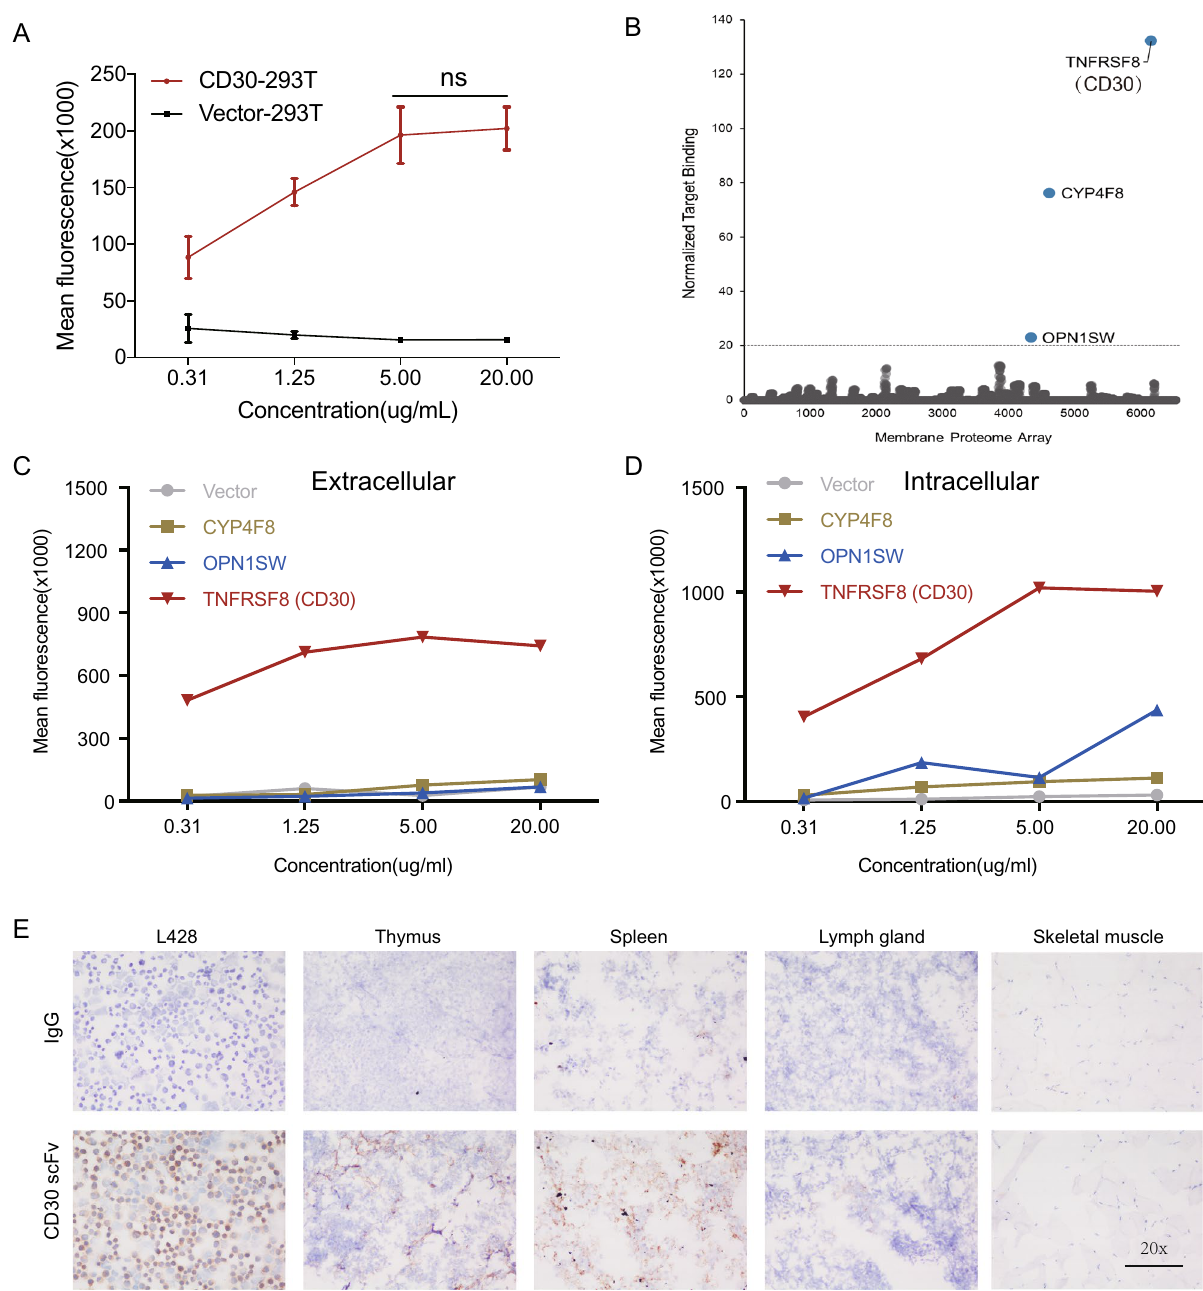
Figure 1. The scFv recognition of CD30 antigen. (A) Binding to the CD30 antigen is increased with increasing concentrations of scFv with 5 μg/ml being the optimal concentration. (B) Binding of scFv to 293 T cells individually expressing 5300 human membrane proteins and measured by Facs analysis using a fluorescently- labelled antibody. Three membrane proteins (TNFRSF8, also known as CD30, CYP4F8 and OPN1SW) were identified as the candidate binding proteins for scFv. (C,D) Cell surface scFv binding to the CD30 (TNFRSF8) molecule (left), but the other two candidate protein targets bound intracellulary. (E) Immunohistochemistry analysis of normal human tissue stained with scFv antibody (IgG as the negative